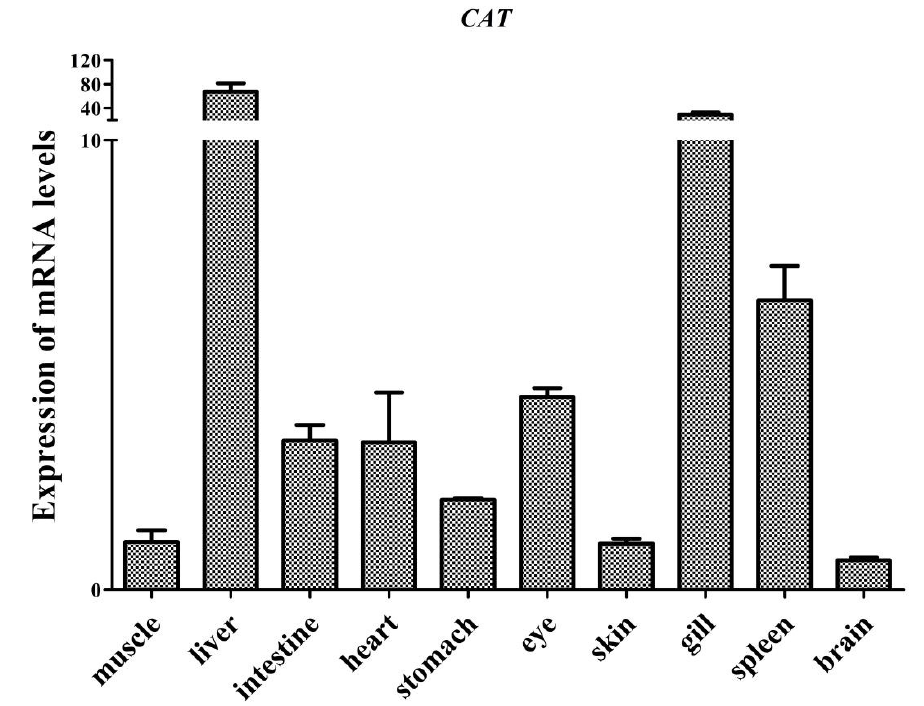
Figure 7. Distribution of AdCAT gene expression in different tissues of Yangtze sturgeon .